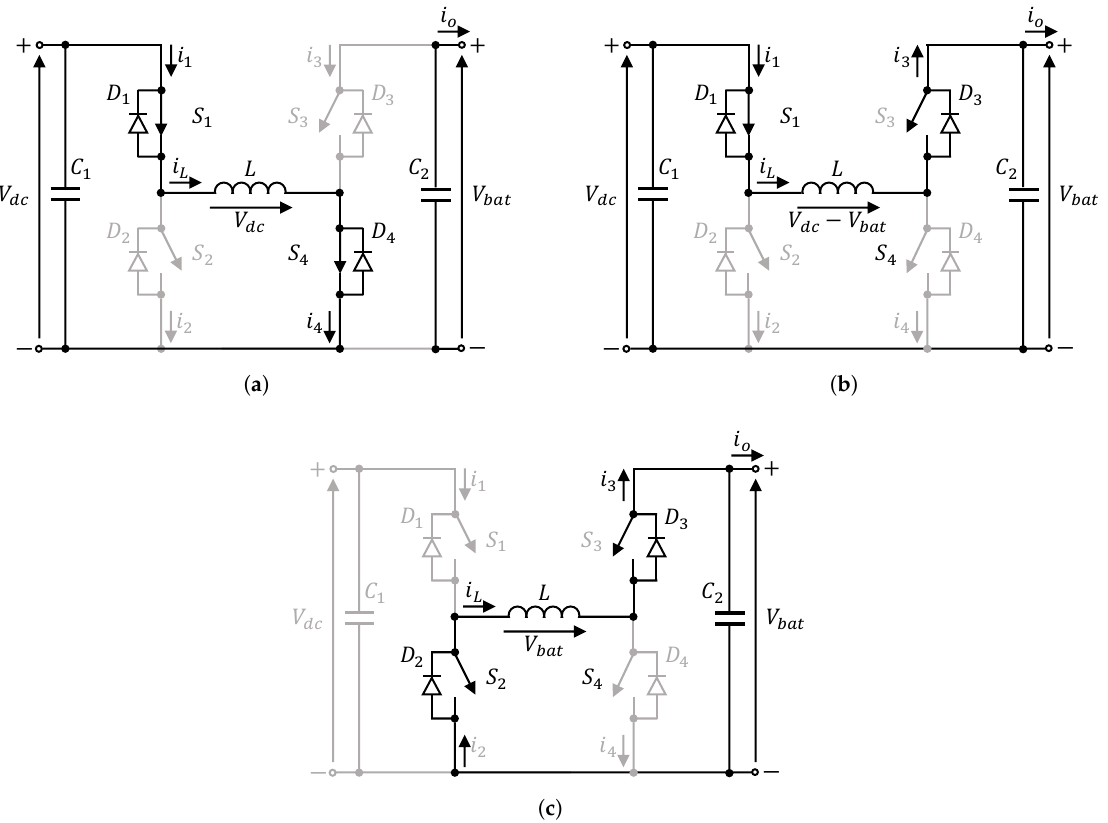
Figure 7. The three operating states of the bidirectional cascaded buck and boost converter in buck + boost mode: ( a ) first operating state in buck + boost mode with switches S 1 and S 4 turned on; ( b ) second operating state in buck + boost mode with switch S 1 turned on and and S 4 turned off; ( c ) third operating state in buck + boost mode with switches S 1 and S 4 turned